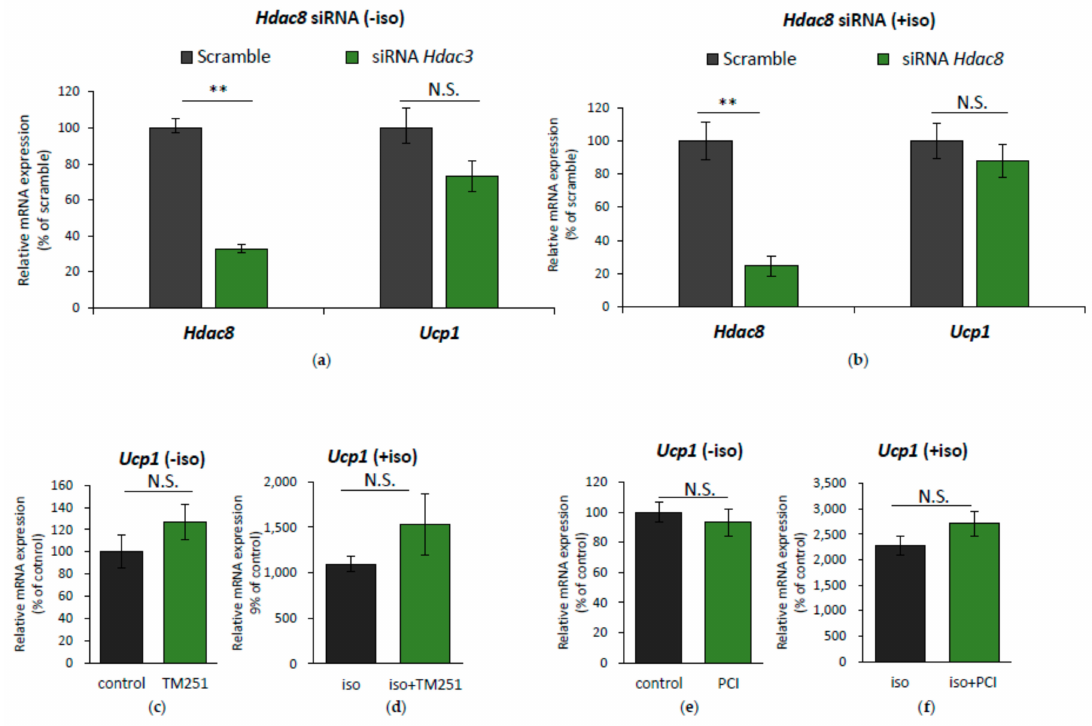
Figure 4. HDAC8 modification has no effect on Ucp1 regulation in IWAT cell. Hdac8 and Ucp1 expression after transfection with Hdac8 siRNA for 24 h without ( a ) or with ( b ) 10 µ M iso induction for 2 h. Ucp1 expression after treatment with 20 µ M HDAC8 activator TM251 without ( c ) or with ( d ) 10 µ M iso induction for 4 h. Ucp1 expression after treatment with 5 µ M HDAC8 inhibitor PCI34051 (PCI) for 24 h without ( e ) or with ( f ) 10 µ M iso induction at the last 4 h. Data are presented as mean ± S.E.M. (error bars). n = 4–6 in each group. ** indicates significant difference ( p < 0.01) according